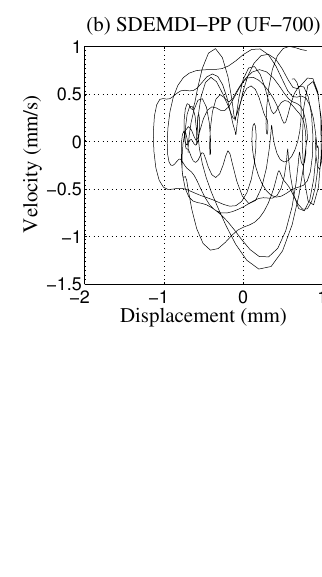
Figure 13. ( a ) Evolution of state variables (ESV); ( b ) phase plane (PP); ( c ) recurrence plot for Case 1 at 700 rpm.